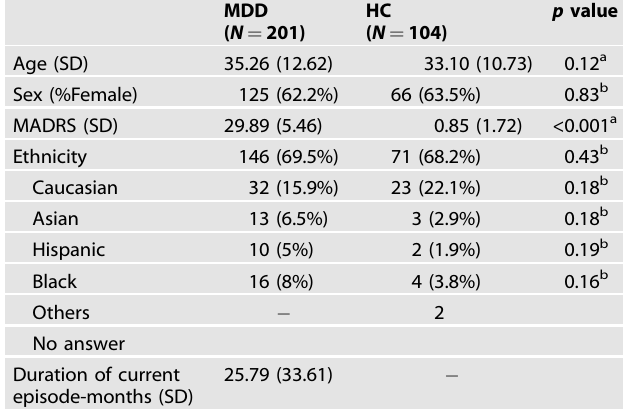
Table 1. Socio-demographic characteristics of study